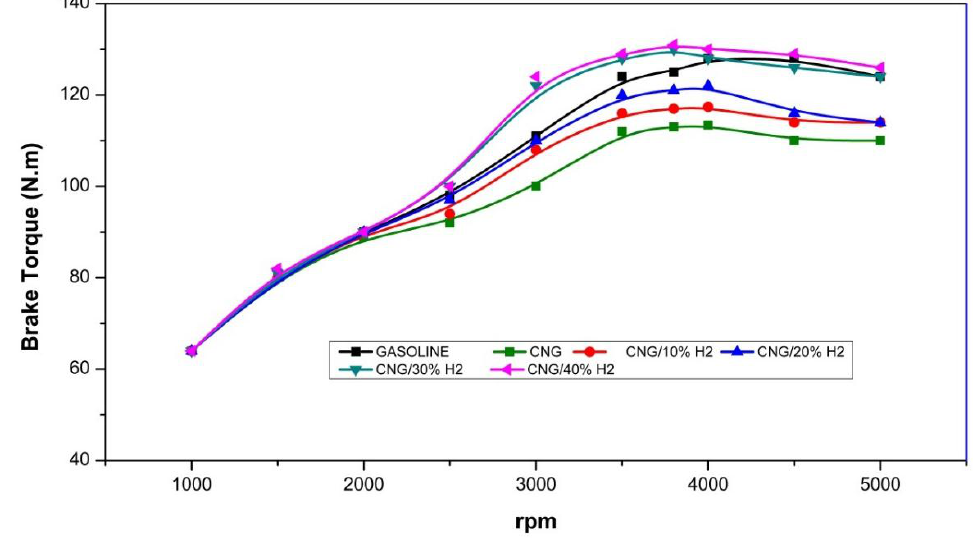
Figure 13. BT In function of engine speed for different hydrogen